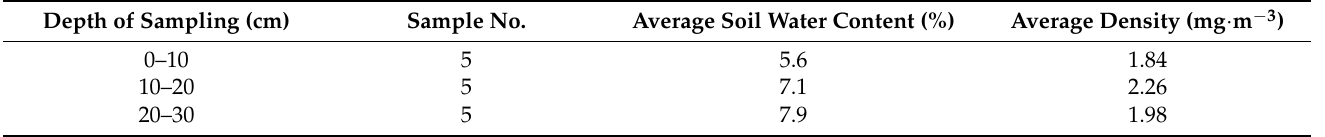
Table 2. Soil water content and bulk density. Depth of Sampling (cm) Sample